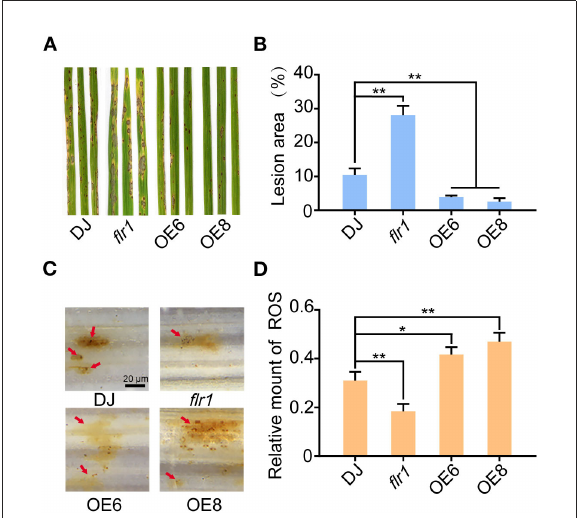
FIGURE1 FLR1 positively regulates rice resistance to Magnaporthe oryzae . (A) Disease phenotypes of leaves of DJ, flr1 , and FLR1-OE plants at 7 dpi. (B) The percentage of lesion areas was calculated by ImageJ software ( n = 5, leaves). (C) DAB staining indicating production of H 2 O 2 at 3 dpi; the red arrows point to appressorium infection sites. Scale bar = 20 µ m. (D) Quantification of H 2 O 2 . The relative amount of H 2 O 2 was calculated via Photoshop on the basis of the pixels of images with the following formula: H 2 O 2 area/rectangle = pixels of H 2 O 2 area/mycelial invasion site/pixels of the rectangle. Error bars represent the SDs of three biological replicates. Asterisks indicate significant differences from the control, as